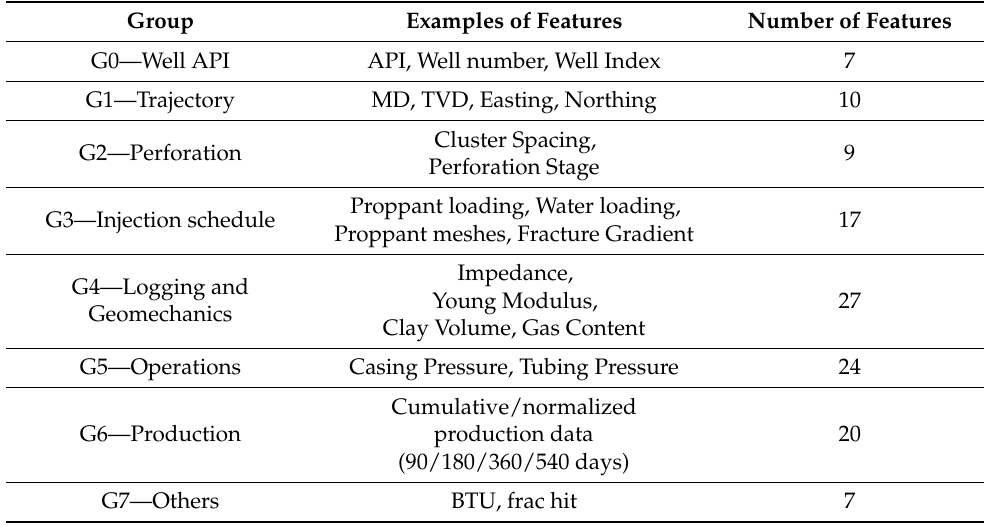
Table 1. Summary of the features in the original